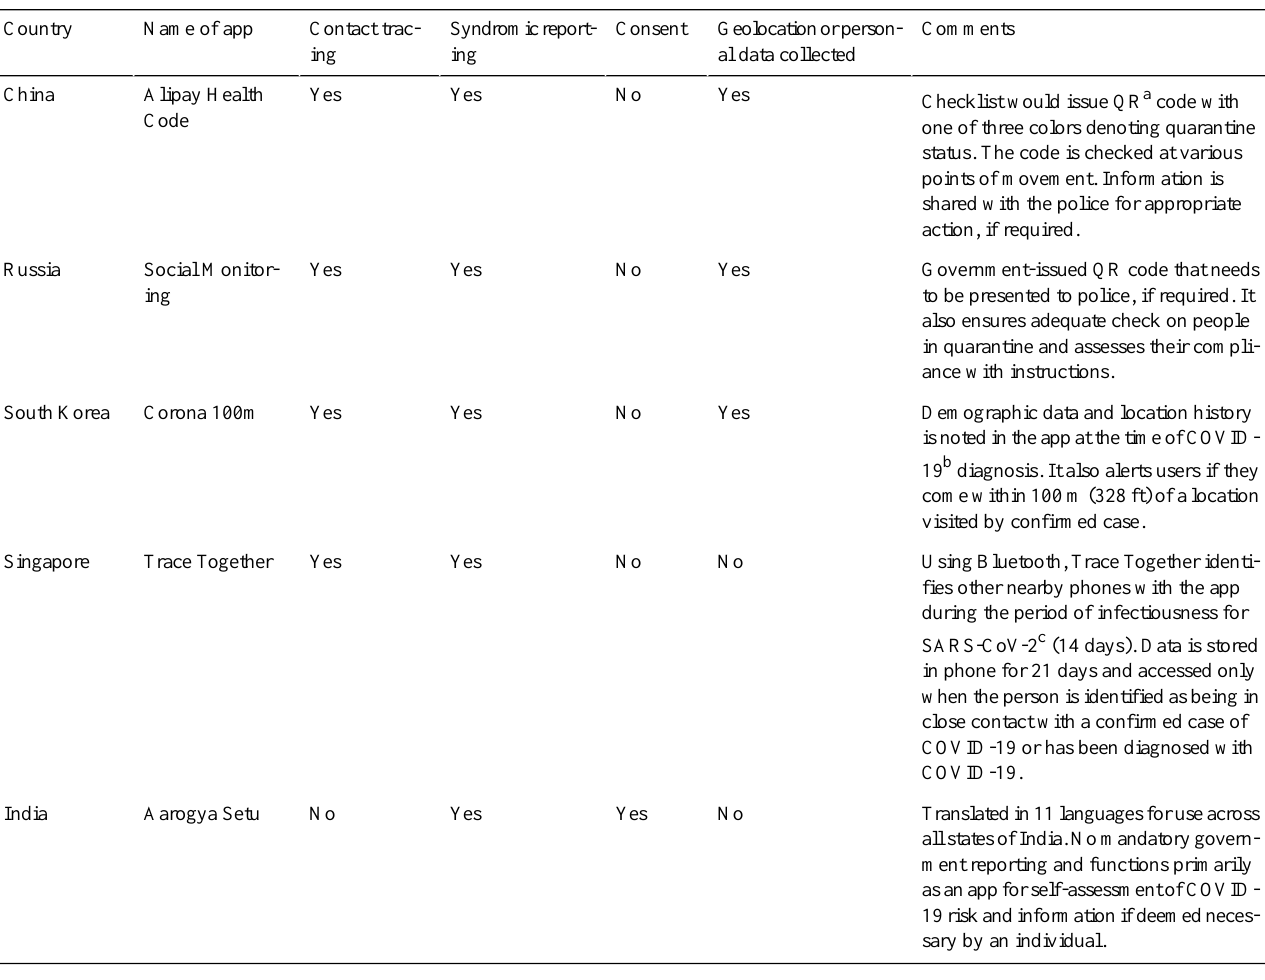
Table 1. Apps available for coronavirus disease surveillance.